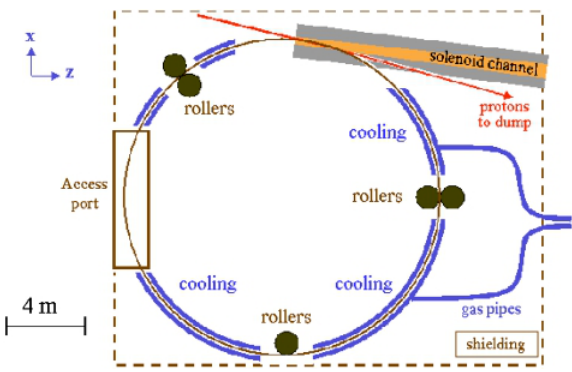
FIG. 17. (Color) Alternative concept of a solid metal target in the form of a rotating Cu-Ni